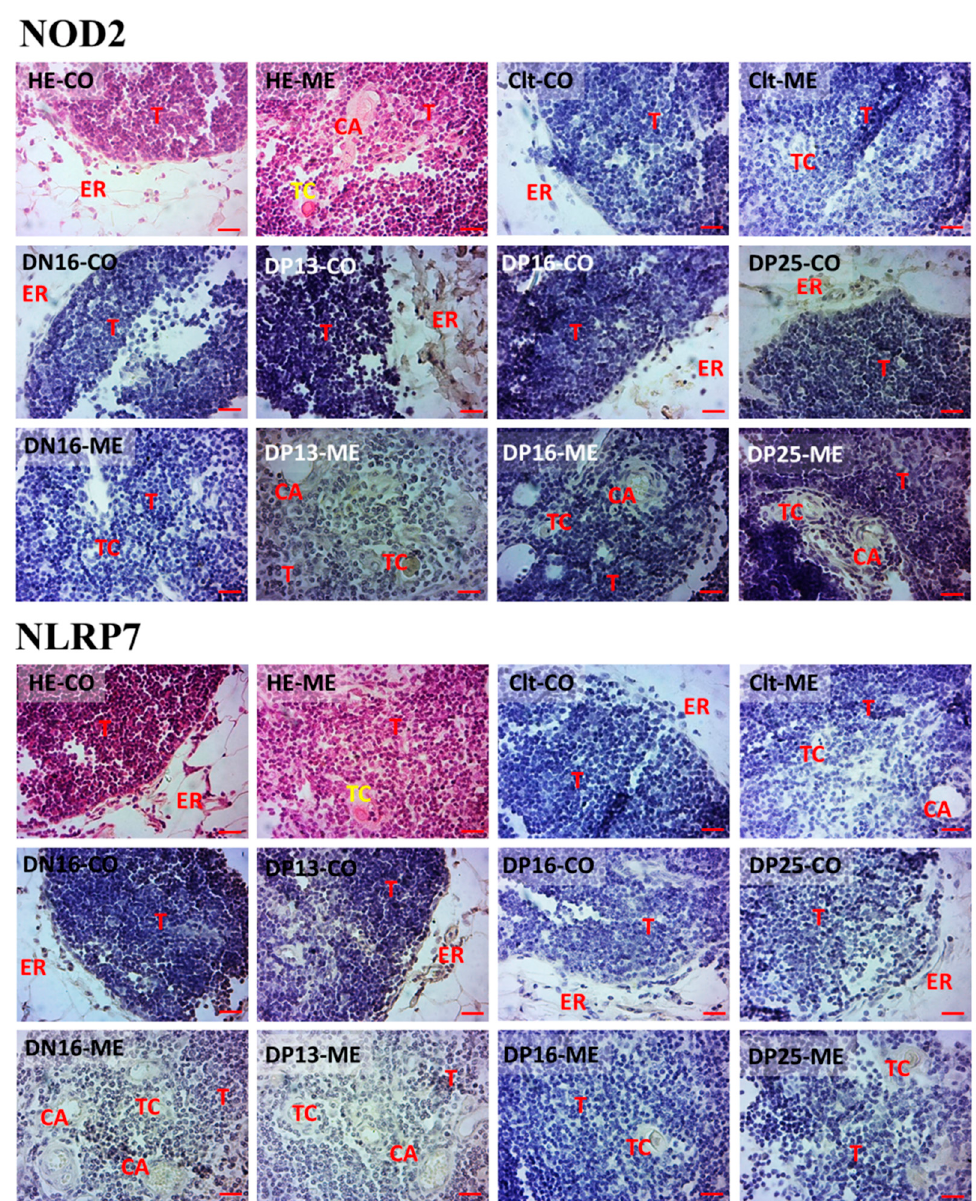
Figure 3. Representative immunohistochemical localization of NOD2 and NLRP7 proteins in the ovine thymus. The thymus is divided into the cortex (CO) and the medulla (ME). Note: HE = stained by hematoxylin and eosin; Ctl = negative control; DN16 = day 16 of the estrous cycle; DP13 = day 13 of pregnancy; DP16 = day 16 of pregnancy; DP25 = day 25 of pregnancy; T = thymocyte; ER = epithelial reticular cell; CA = capillary; TC = thymic corpuscle. Bar = 20 µm.